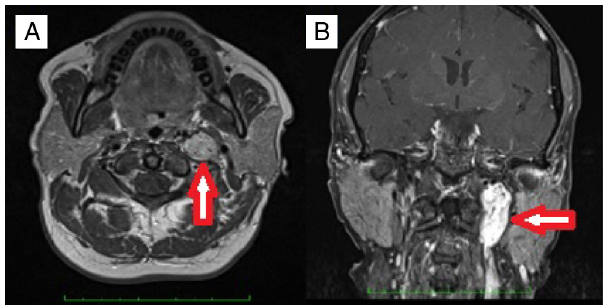
A case of left sided TJP with typical salt and pepper appearance; meaning areas of high and low intensity on MRI.